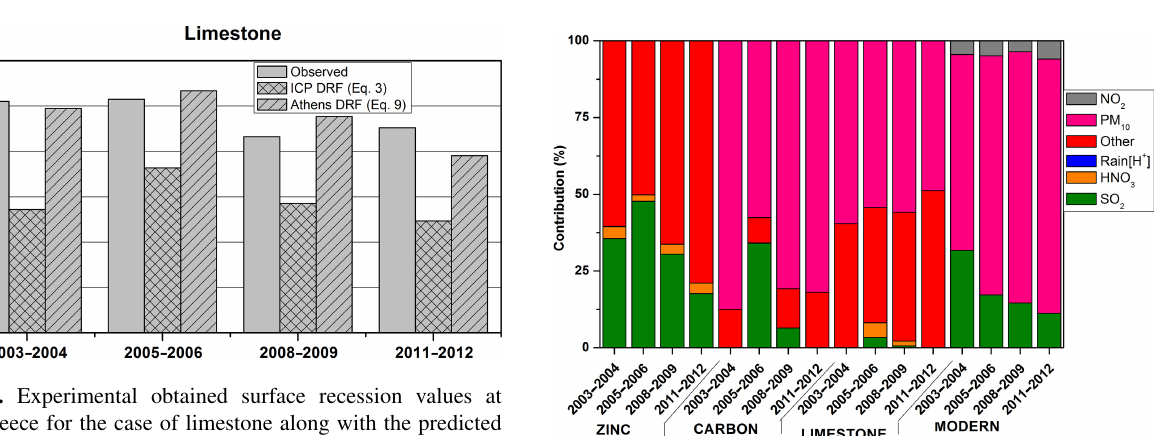
Figure 11. Experimental obtained haze values at Athens, Greece for the case of modern glass along with the predicted values by DRFs.